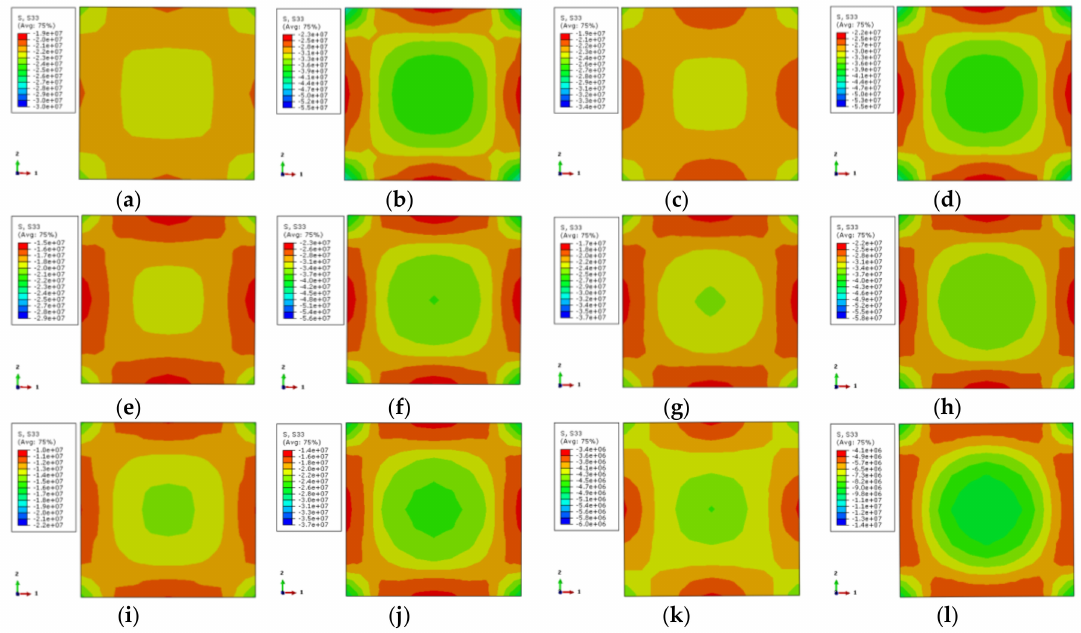
Figure 11. Stress distribution of concrete in the middle cross section of columns ( a ) DS-20-0.75; ( b ) DS-20-1; ( c ) DS-100-0.75; ( d ) DS-100-1; ( e ) DS-200-0.75; ( f ) DS-200-1; ( g ) DS-400-0.75; ( h ) DS-400-1; ( i ) DS-600-0.75; ( j ) DS-600-1; ( k ) DS-800-0.75; ( l )